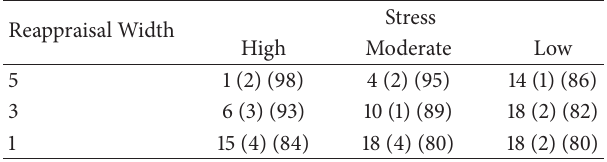
Table 2: Results for the depressed agent. Table 3: Results for the agent which has 60% chance evoking negative